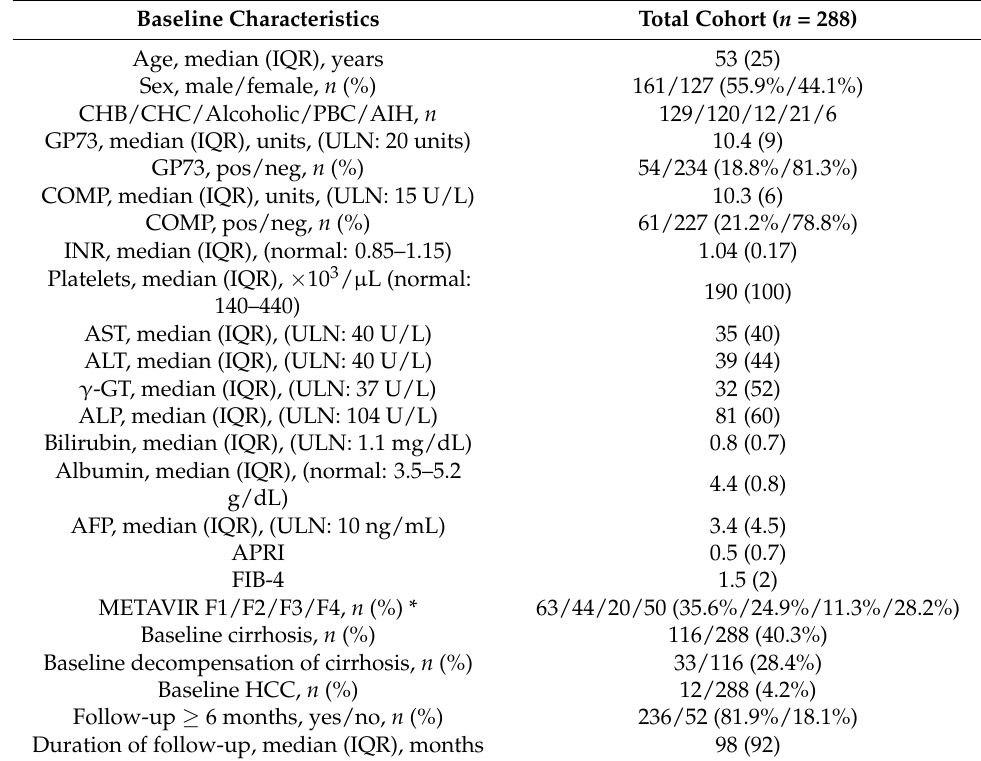
Table 1. Baseline demographic, biochemical, histological, and clinical characteristics of